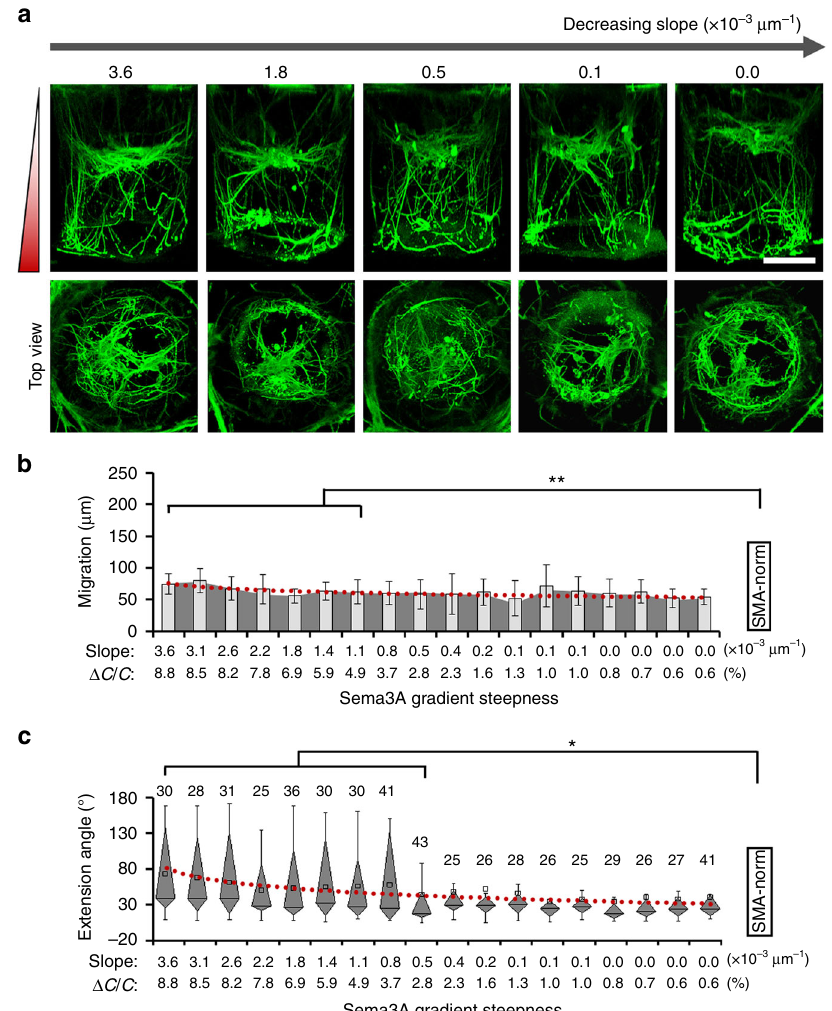
Fig. 6 GSK3 ’ s involvement in steepness-dependent regulation of neuronal migration. a Fluorescence images of neurons in Sema3A gradient of varied steepness after inhibition of the GSK3 activity. Scale bar: 100 µ m. b Quantitative analysis of GSK3 ’ s role in neuronal migration and related association with the Sema3A gradient steepness, n = 3, error bars indicate standard deviation. c Box-plots for quantitative analysis of GSK3 ’ s role in the chemorepellent guidance of neurite outgrowth in response to the varied Sema3A gradient steepness. The parts of the box indicate 25, 50, and 75 percentiles, and the whiskers indicate 5% and 95%. The square mark indicates mean of the data. More than 25 neurites (as indicated on top of each box) were pooled from three biological replicates. For b , c , the dot-lines (red) indicate logarithmic fi tting of the data mean; neuronal growth pattern in each hydrogel cylinder was compared in pairwise to experiments with regular Sema3A treatment (SMA-norm), * or ** indicates a p -value < 0.05 or <0.005 by paired Kruskal –